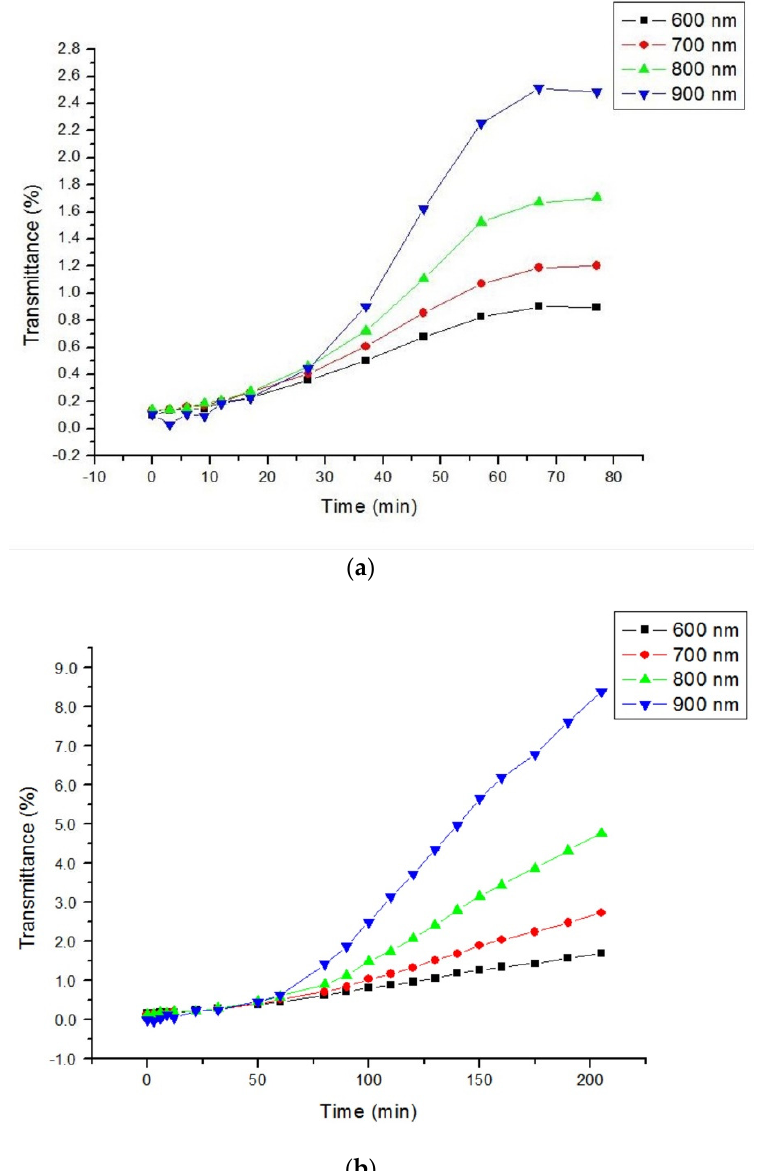
Figure 5. The kinetics of collimated transmittance at impregnation of the sample by: ( a ) aqueous 40% glucose solution; ( b ) at impregnation of the sample by aqueous 50% DMSO solution. All experimental errors expressed as SD were less than the size of point icons.